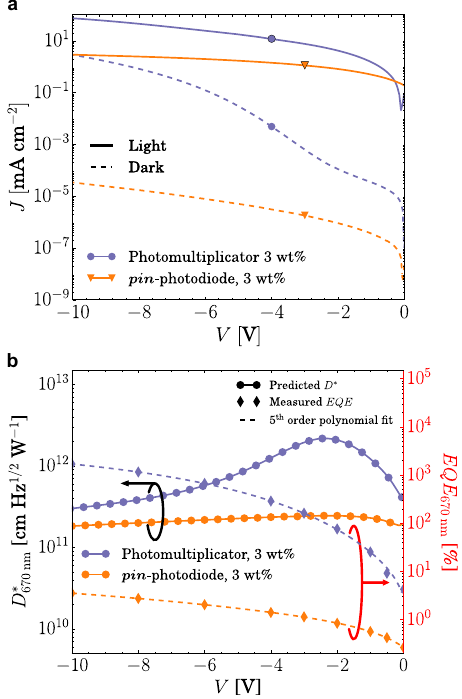
Fig. 3 Comparison of a PM-OPD and an equivalent pin-photodiode. a JV characteristics in dark and under 100 mW cm − 2 illumination of a pin- photodiode and of a PM-OPD. b The EQE measured at different voltages is fi tted with polynomial function from which the detectivity is predicted. The total noise is calculated from the shot and thermal noise, which are obtained from the dark current and the shunt resistance at room temperature, respectively. The PM-OPD shows a maximum D * of 2.2 × 10 12 Jones around − 2.5 V, which is higher than D * of the equivalent pin- photodiode over the entire range measured, besides the high dark current at high reverse bias. The pin-photodiode comprises the same structure shown in Fig. 1c, except for the ETL, where instead of HATNA-Cl 6 , BPhen (8 nm) is used, see Supplementary Fig.